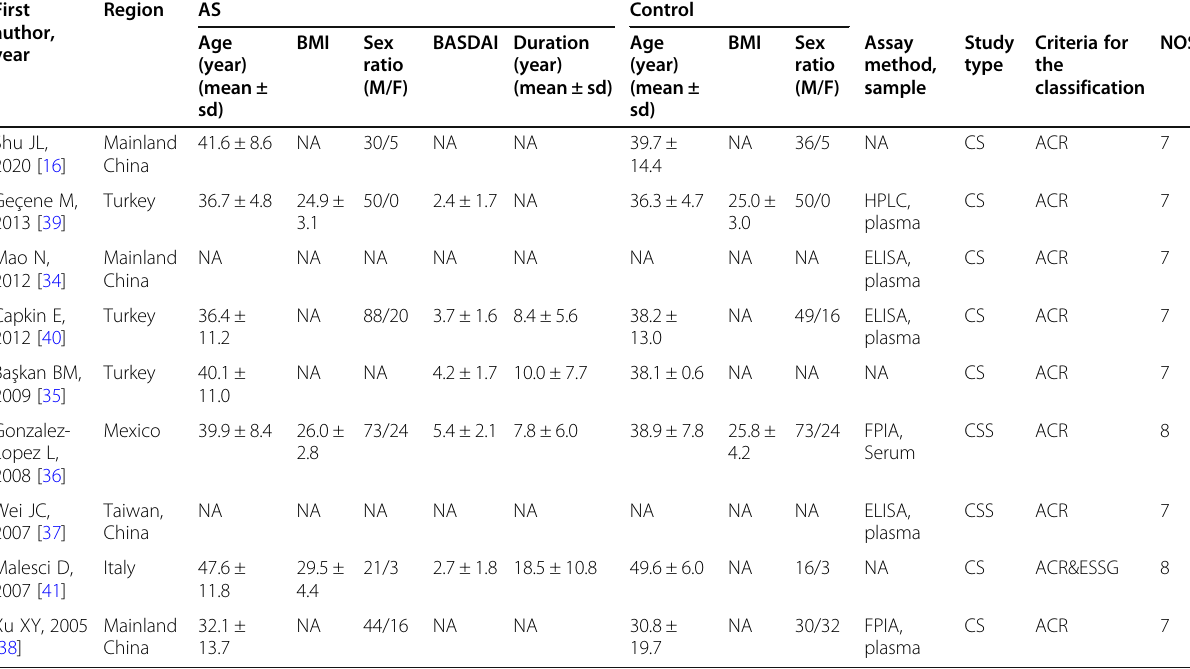
Table 1 Characteristics of individual studies included